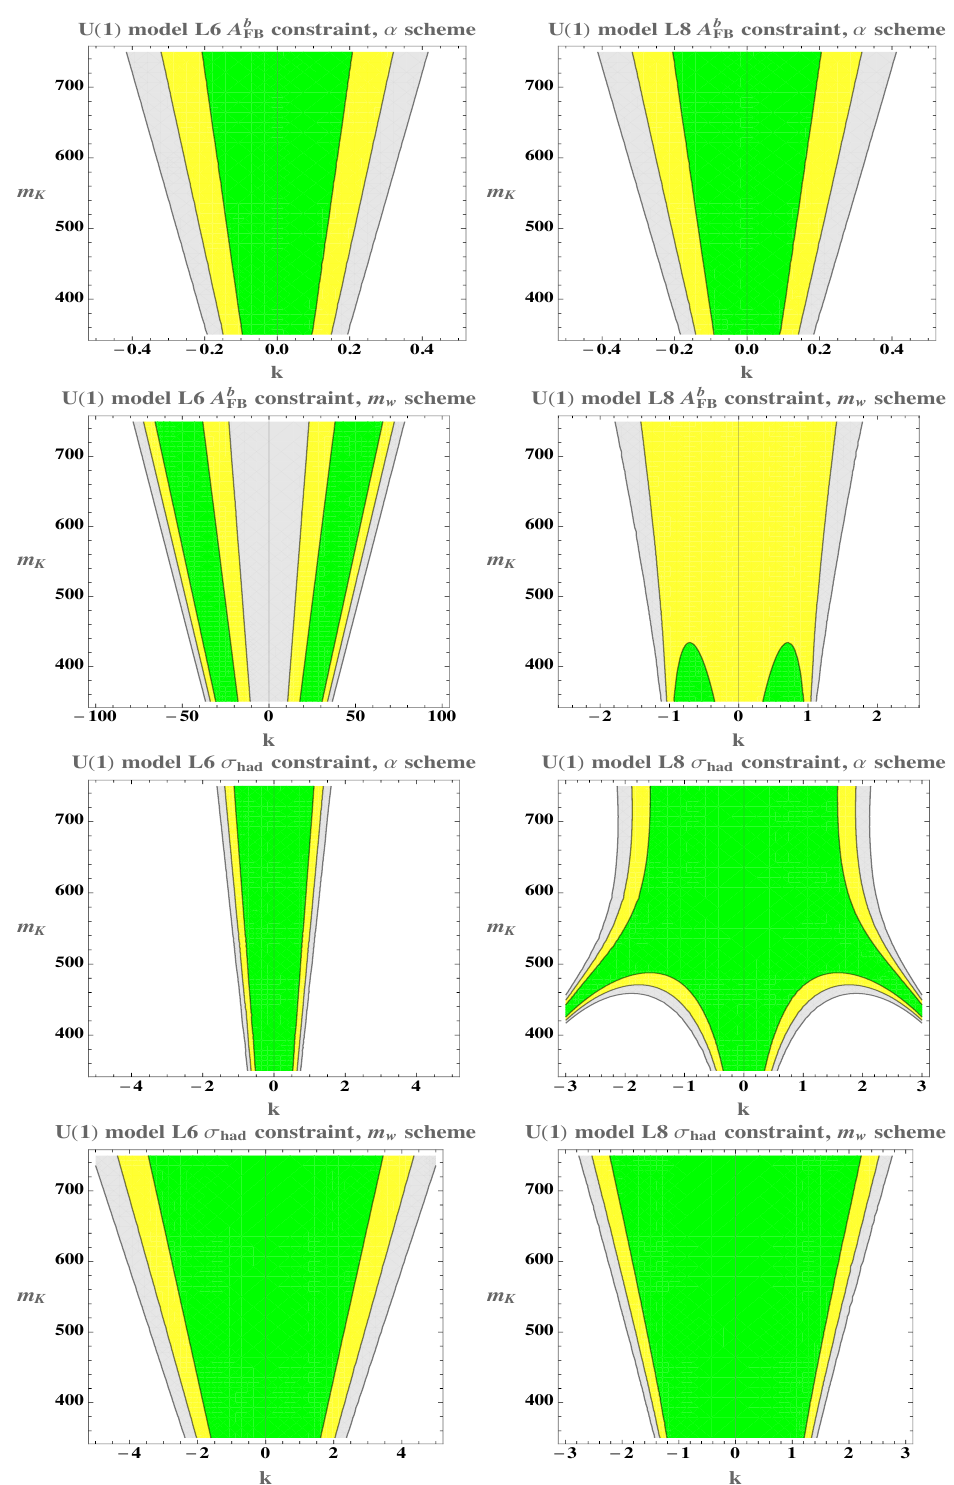
Figure 7 . Shown are the constraints on the model space from the A b